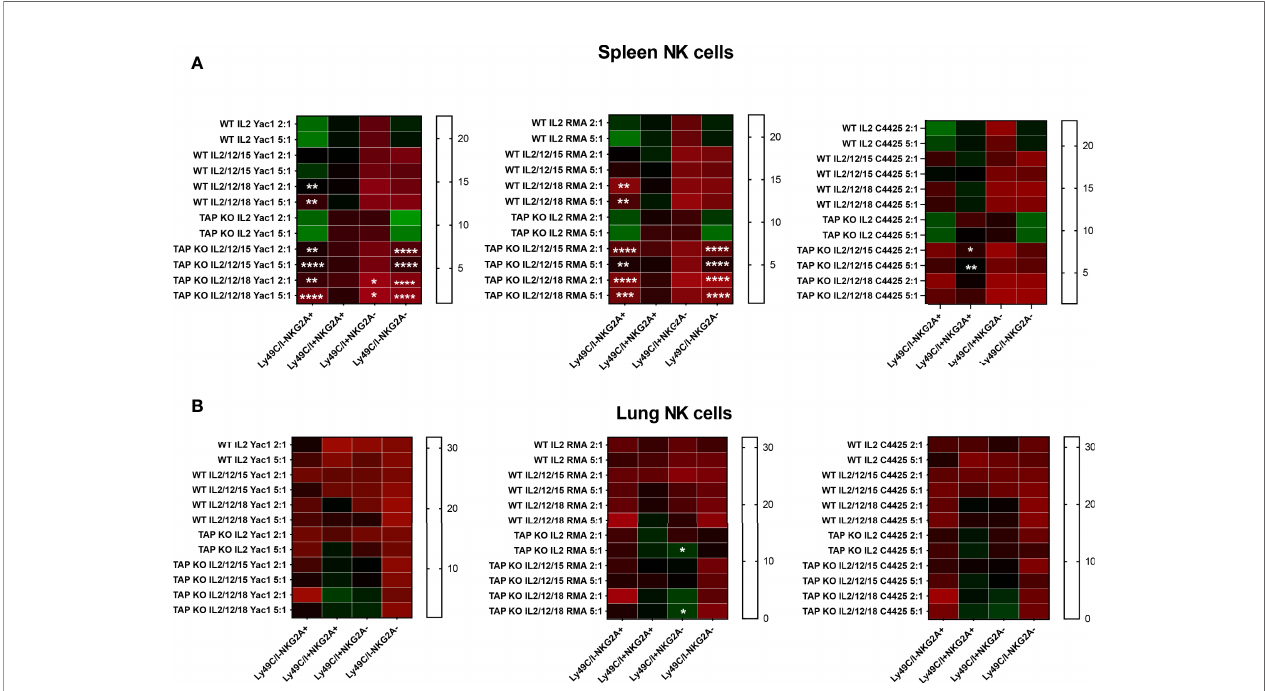
FIGURE 11 | (A) NK cells derived from murine spleen were expanded in the presence of IL-2 for fi ve days and then restimulated with IL-2 alone, or (IL-2, IL-12, IL- 15) or (IL-2, IL-12, IL-18) cytokines overnight. These cells were then co-cultured with the targets YAC-1, RMA and C4.4-25- for four hours. The stimulated cells were investigated for CD107a expression among CD3-NK1.1+ NK cells by fl ow cytometry staining. The expression levels were divided into four NK cell subsets based on the presence or absence of NKG2A and Ly49C/I. Statistical analysis was performed using GraphPad Prism 9.0.0 with an ordinary two-way ANOVA with Tukey ’ s multiple comparisons tests (n=3). *, p<0.05, **, p<0.01, ***, p<0.001 and ****, p<0.0001. (B) Same experiments, but with NK cells derived from murine